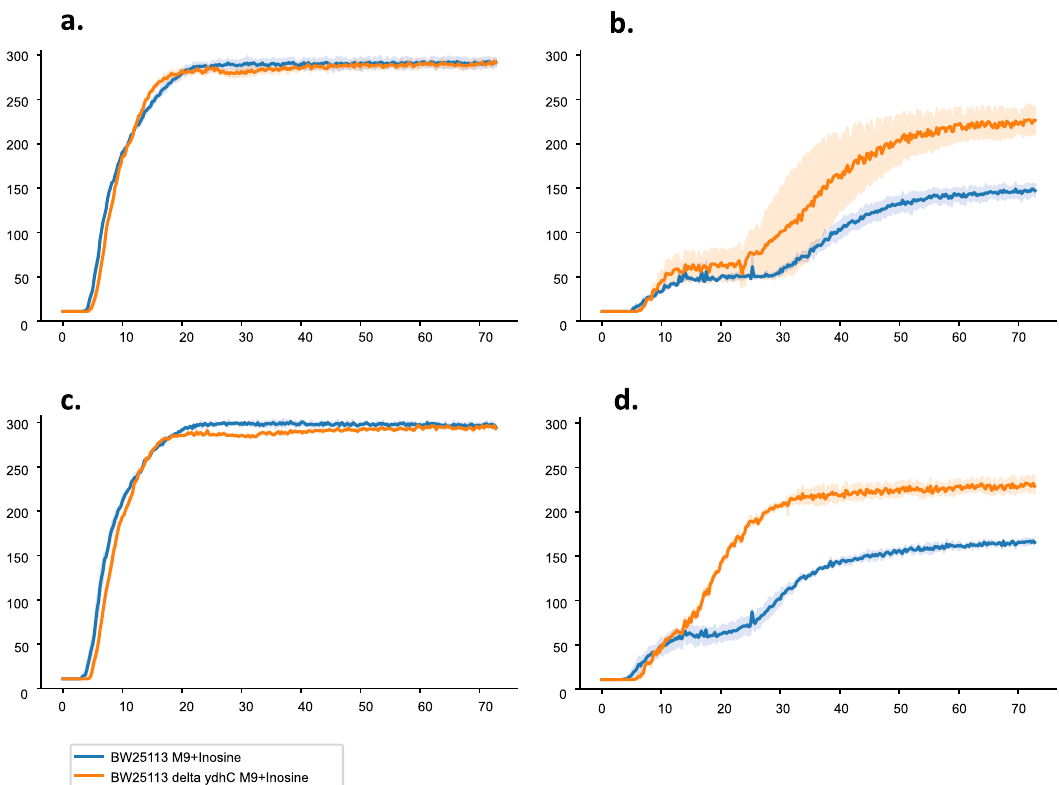
Fig. 7 The phenotypes of the E. coli BW25113 and punC knockout strains in the Biolog plate PM12B supplemented with 1 mM inosine. Resistance to: a , b sulfathiazole_1X and 8X, and c , d sulfamethoxazole_1X and 8X (folate antagonists). The other antibiotics tested at four different concentrations are penicillin G, tetracycline, carbenicillin, oxacillin, penimepicyclin, polymyxin B, paromomycin, vancomycin, D,L-serine hydroxamate, sisomycin, sulfamethazine, novobiocin, 2,4-diamino-6,7-diisopropyl-pteridine, sulfadiazine, benzethonium chloride, tobramycin, 5- fl uoroorotate, spectinomycin, L- aspartic-b-hydroxamate, spiramycin, rifampicin and dodecyltrimethyl ammonium